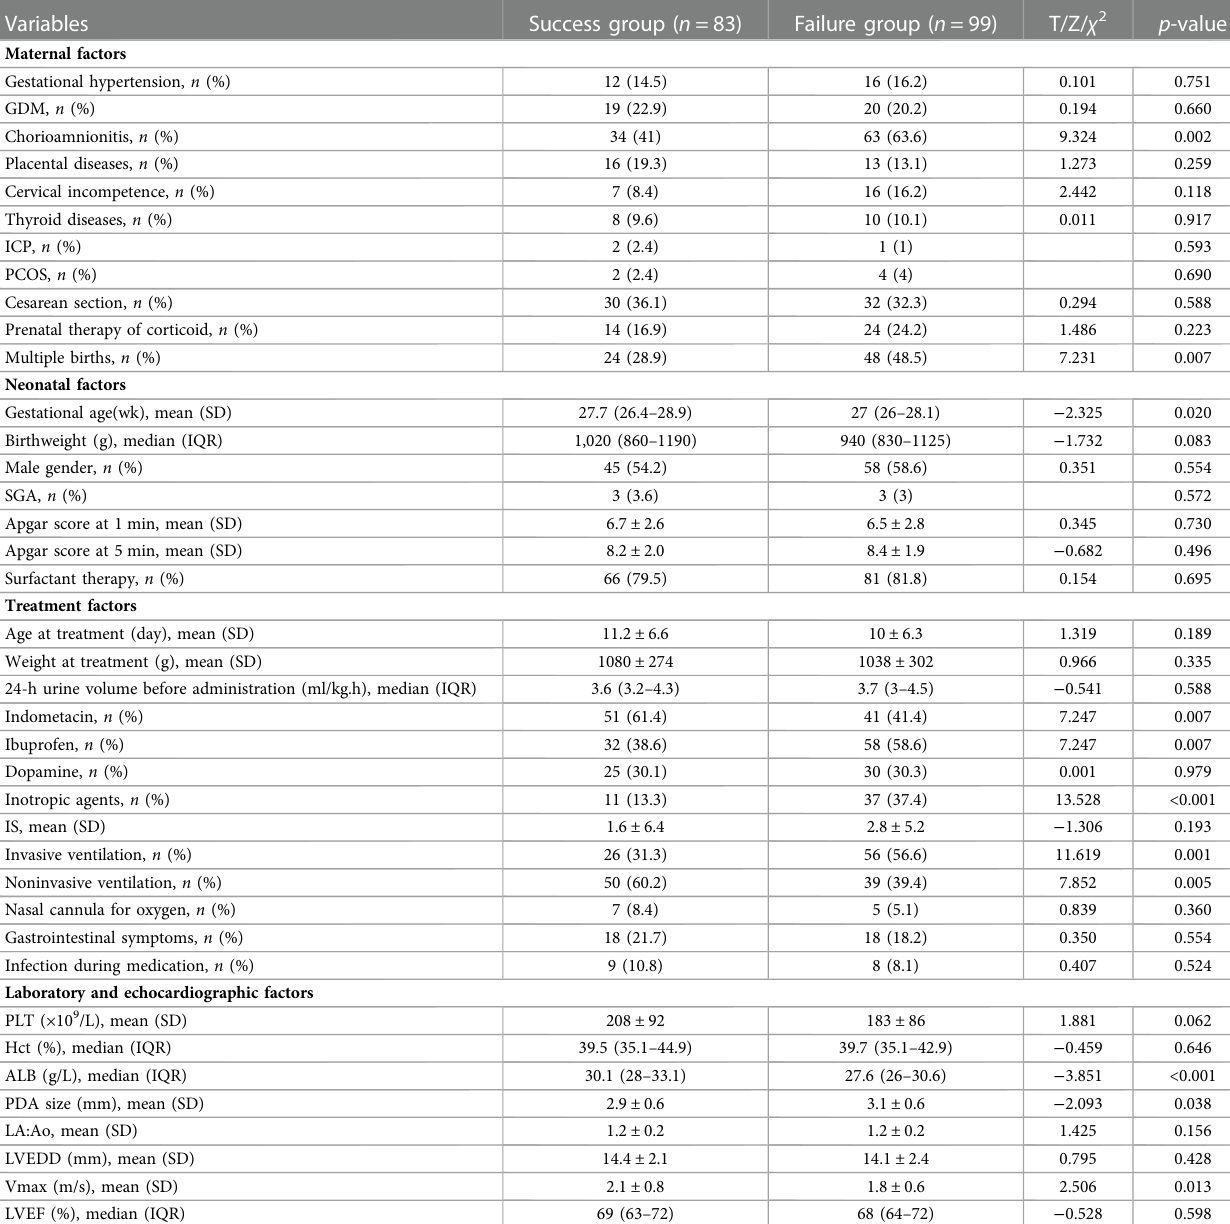
TABLE 1 Demographic